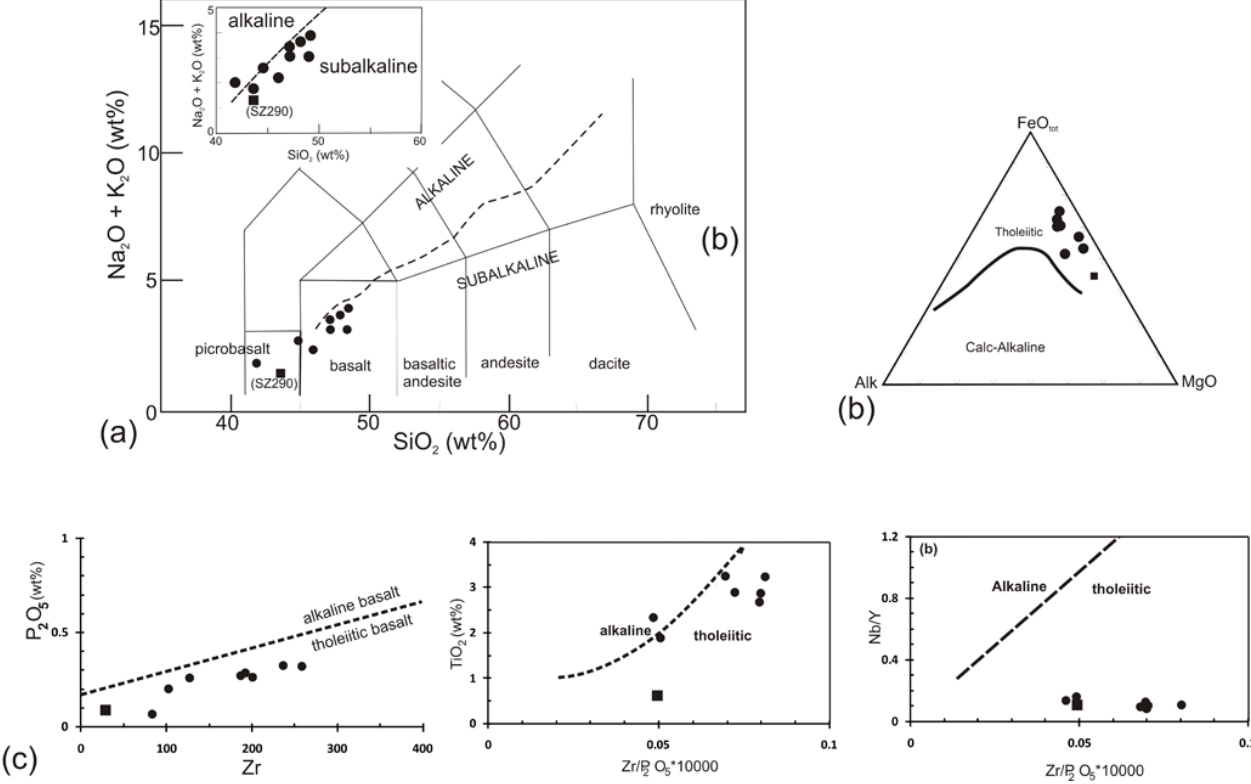
Fig. 5. Classification diagrams for the Sabzevar granulites. (a) Plot of total alkali vs. silica (Le Bas et al., 1992); (b) AFM diagram after Irivine and Baragar (1971); (c) after Winchester and Floyd (1976). Key to symbols: square is sample SZ290.